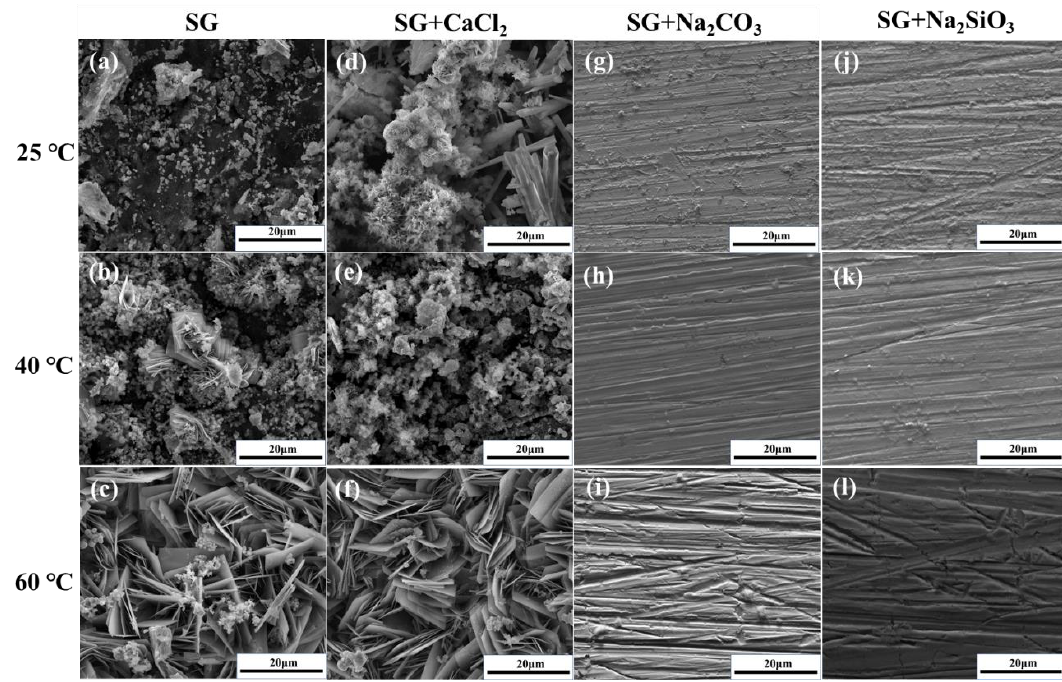
Figure 8. Surface morphology of iron after 4 weeks immersion in 20 mM SG and SG + CaCl 2 /Na 2 CO 3 /Na 2 SiO 3 solutions. Na / Na 2 CO 3 2 SiO 3 solutions ( a – l